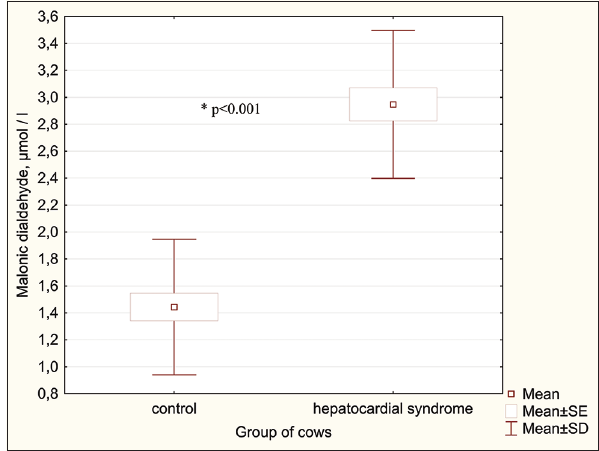
Figure-2: Serum concentration of malondialdehyde and ceruloplasmin in cows with hepatocardial